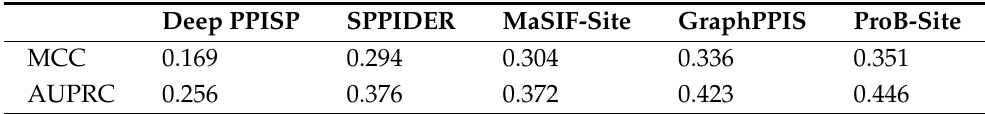
Table 4. Performance comparison of proposed model (ProB-site) with previous models using test_315